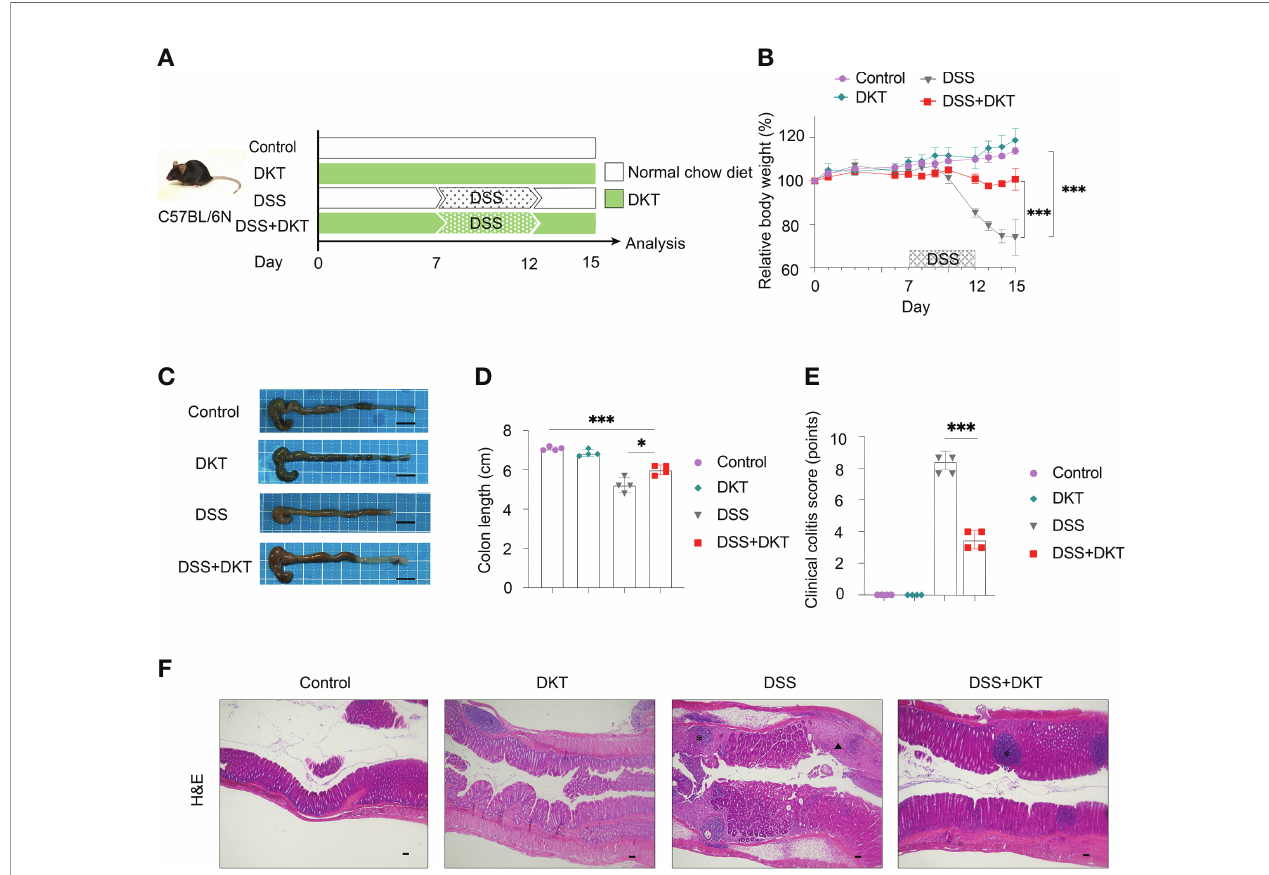
FIGURE 1 | DKT alleviates the symptoms and pathology of dextran sodium sulfate (DSS)-induced acute colitis. (A) Experimental schematic: C57BL/6 mice were divided into four groups: a normal chow diet group (Control), a group given 5% DKT extract mixed in normal chow diet (DKT), a 2.5% DSS-induced colitis group (DSS), and a group of 2.5% DSS-colitis mice fed the same diet as the DKT group (DSS+DKT). 2.5% DSS in drinking water was administered beginning on day 7 and continued for 5 days, followed by a three-day DSS-free period. The mice were sacri fi ced on day 15. (B) Body weight changes over the course of the experiment (N=4 per group). (C) Representative macroscopic images of the colon post-mortem (N=4 per group). Scale bars represent 1 cm. (D) Colon lengths were measured from the proximal colon to the rectum post-mortem (N=4 per group). (E) Clinical colitis scores of the four experimental groups on day 15, measured in a blind fashion (N=4 per group). (F) Representative histology of H&E-stained longitudinal sections of the rectal colon (Control N=4, DKT N=4, DSS N=5, DSS+DKT N=5). Scale bars represent 100 m m. *indicates the isolated lymphoid follicles. The triangle indicates the ulceration. Each symbol (D, E) represents data from an individual mouse. Results are representative of two or three independent experiments with three to four mice in each experimental group. Graph (B, D, E) show means ± SEM; *p<0.05, and ***p<0.001. Statistical analysis was performed using One-way ANOVA with Tukey ’ s multiple comparisons